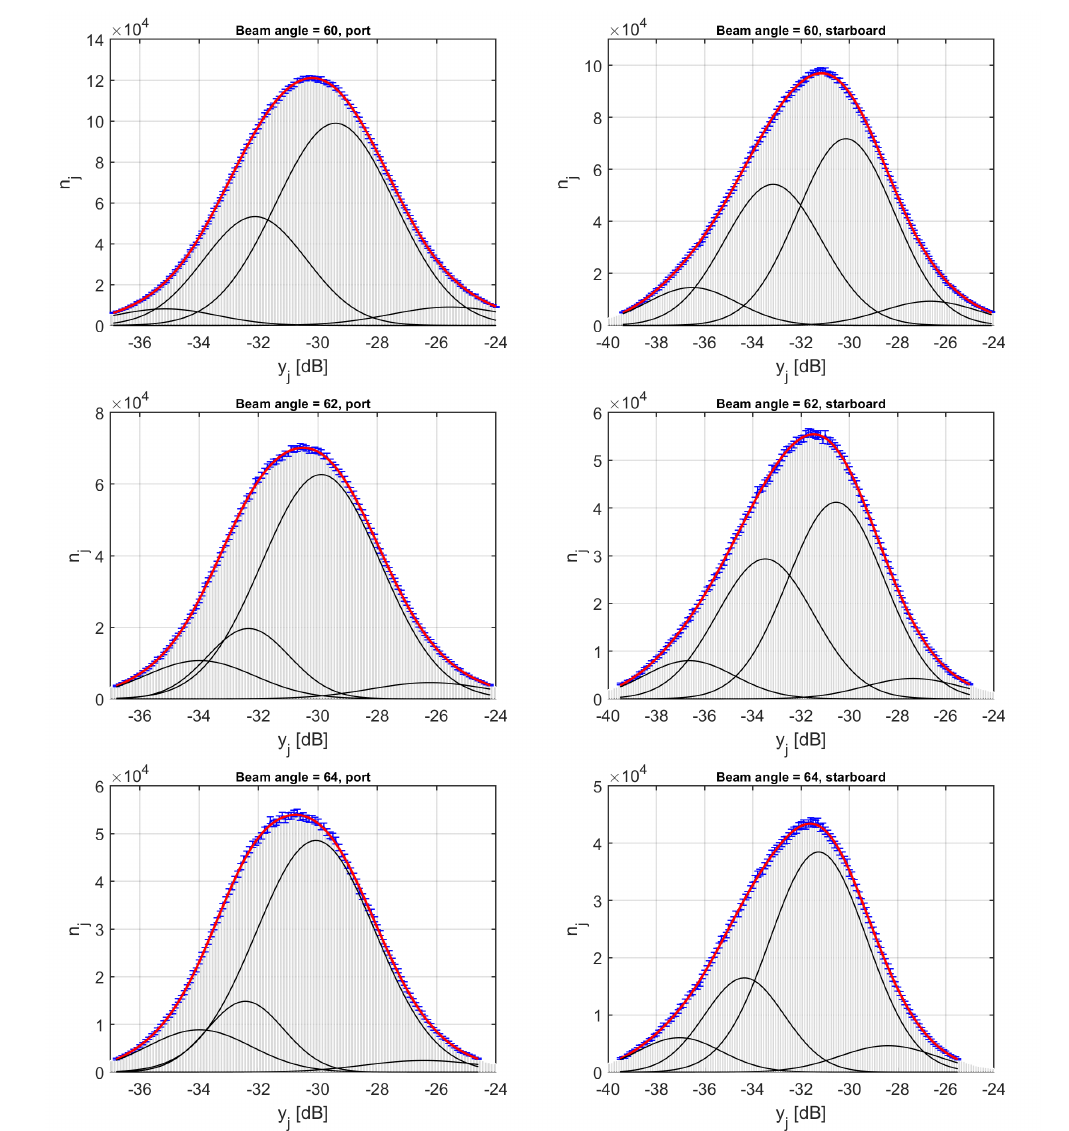
Figure 6. Measured histograms for grazing angles 30 ◦ , 28 ◦ , and 26 ◦ for both port and starboard sides, in gray; sum of m = 4 number of Gaussians, in red (see: Equation (4)), individual Gaussians are in black. Error bars (in blue) were multiplied by a factor of 3 for